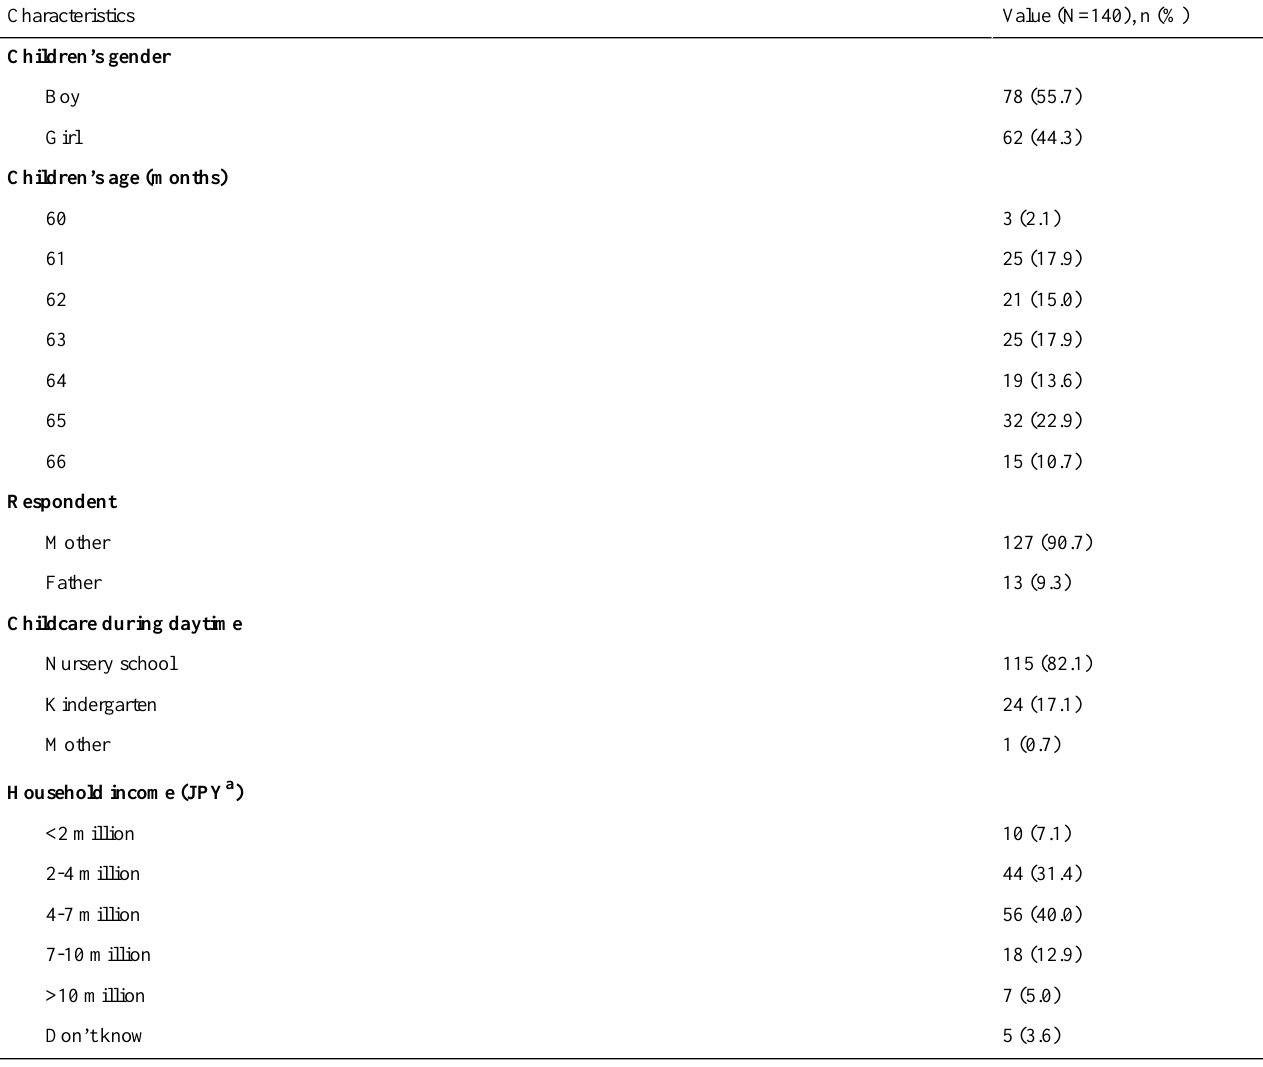
Table 1. Participants’demographic